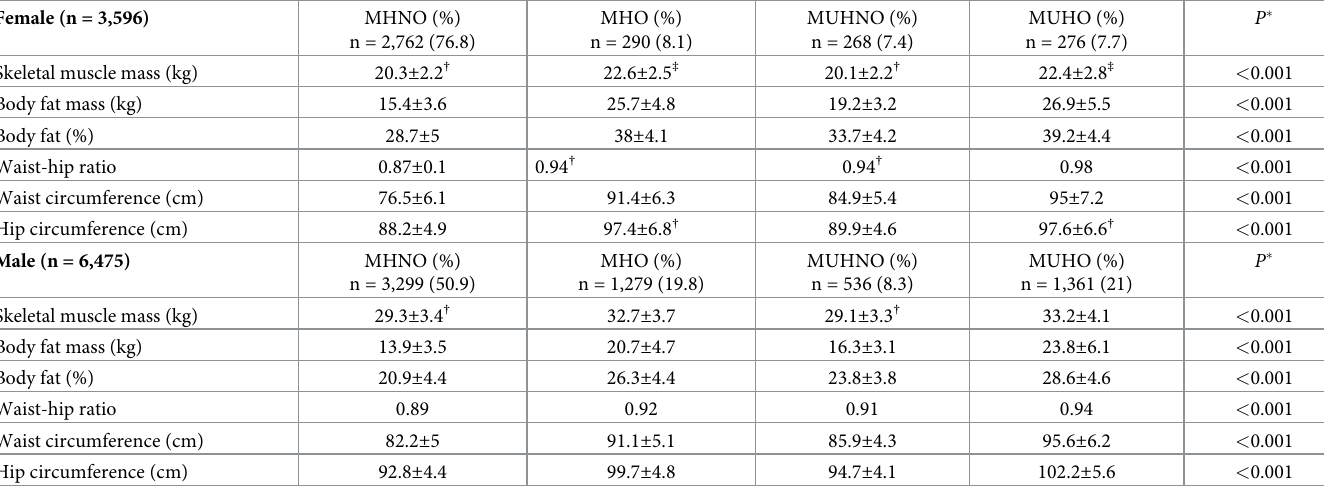
Table 3. Body composition variables in both sexes divided according to metabolic health and obesity